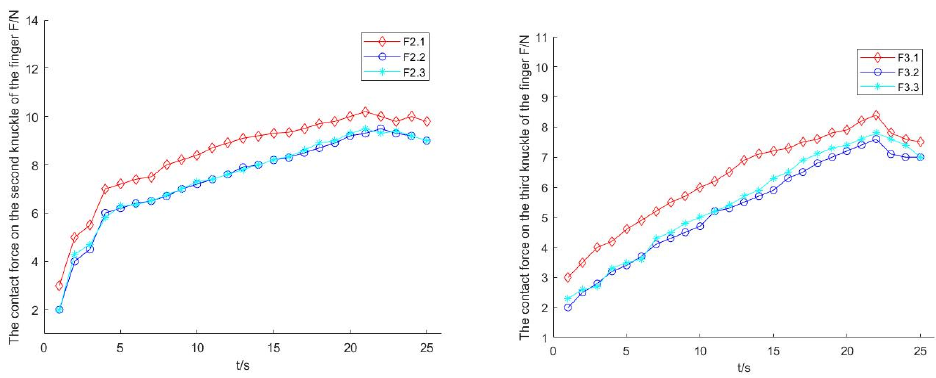
Figure 18. Contact force of the second and third knuckles when grasping the cylinder.